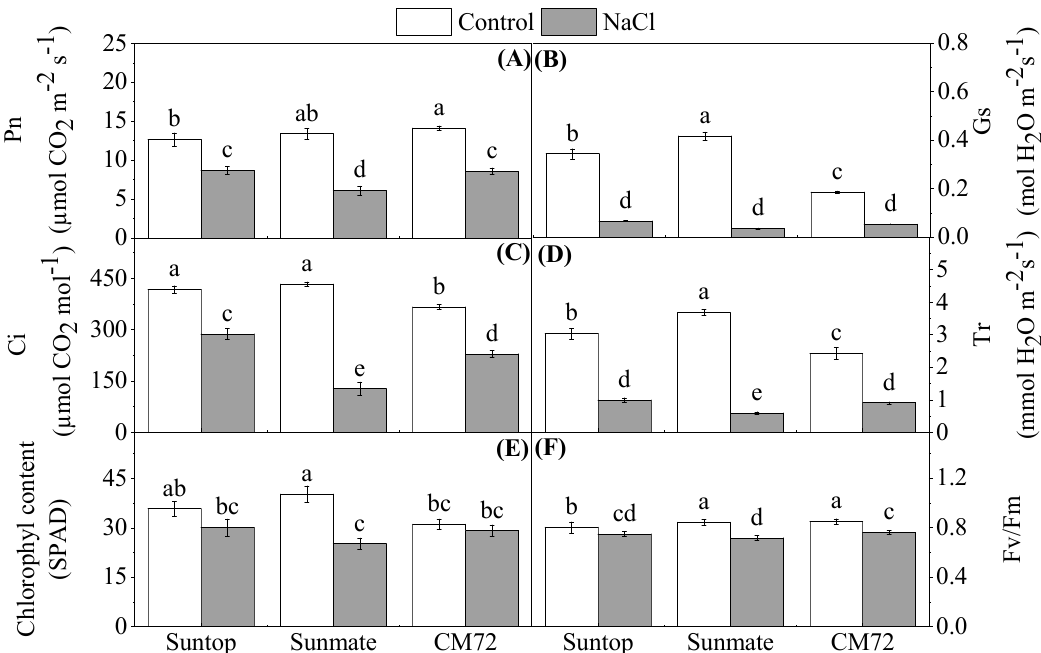
Figure 2. E ff ect of salinity stress on photosynthetic traits in two wheat cv., Suntop and Sunmate, and the barley cv., CM72, 25 days after treatment with 100 mM NaCl. Pn ( A ), Gs ( B ), Ci ( C ), Tr ( D ) and Fv / Fm ( F ), represent net photosynthetic rate, stomatal conductance, intercellular CO 2 concentration, transpiration rate, and a maximum quantum yield of photosystem II photochemistry of the second fully expanded leaves, respectively. The chlorophyll content was measured as SPAD ( E ) (Soil Plant analysis Development). Values are means + SE ( n = 4). For each parameter, means annotated with the same letter are not significantly di ff erent from each other according to Duncan’s Multiple Range Tests at p ≤ 0.05.